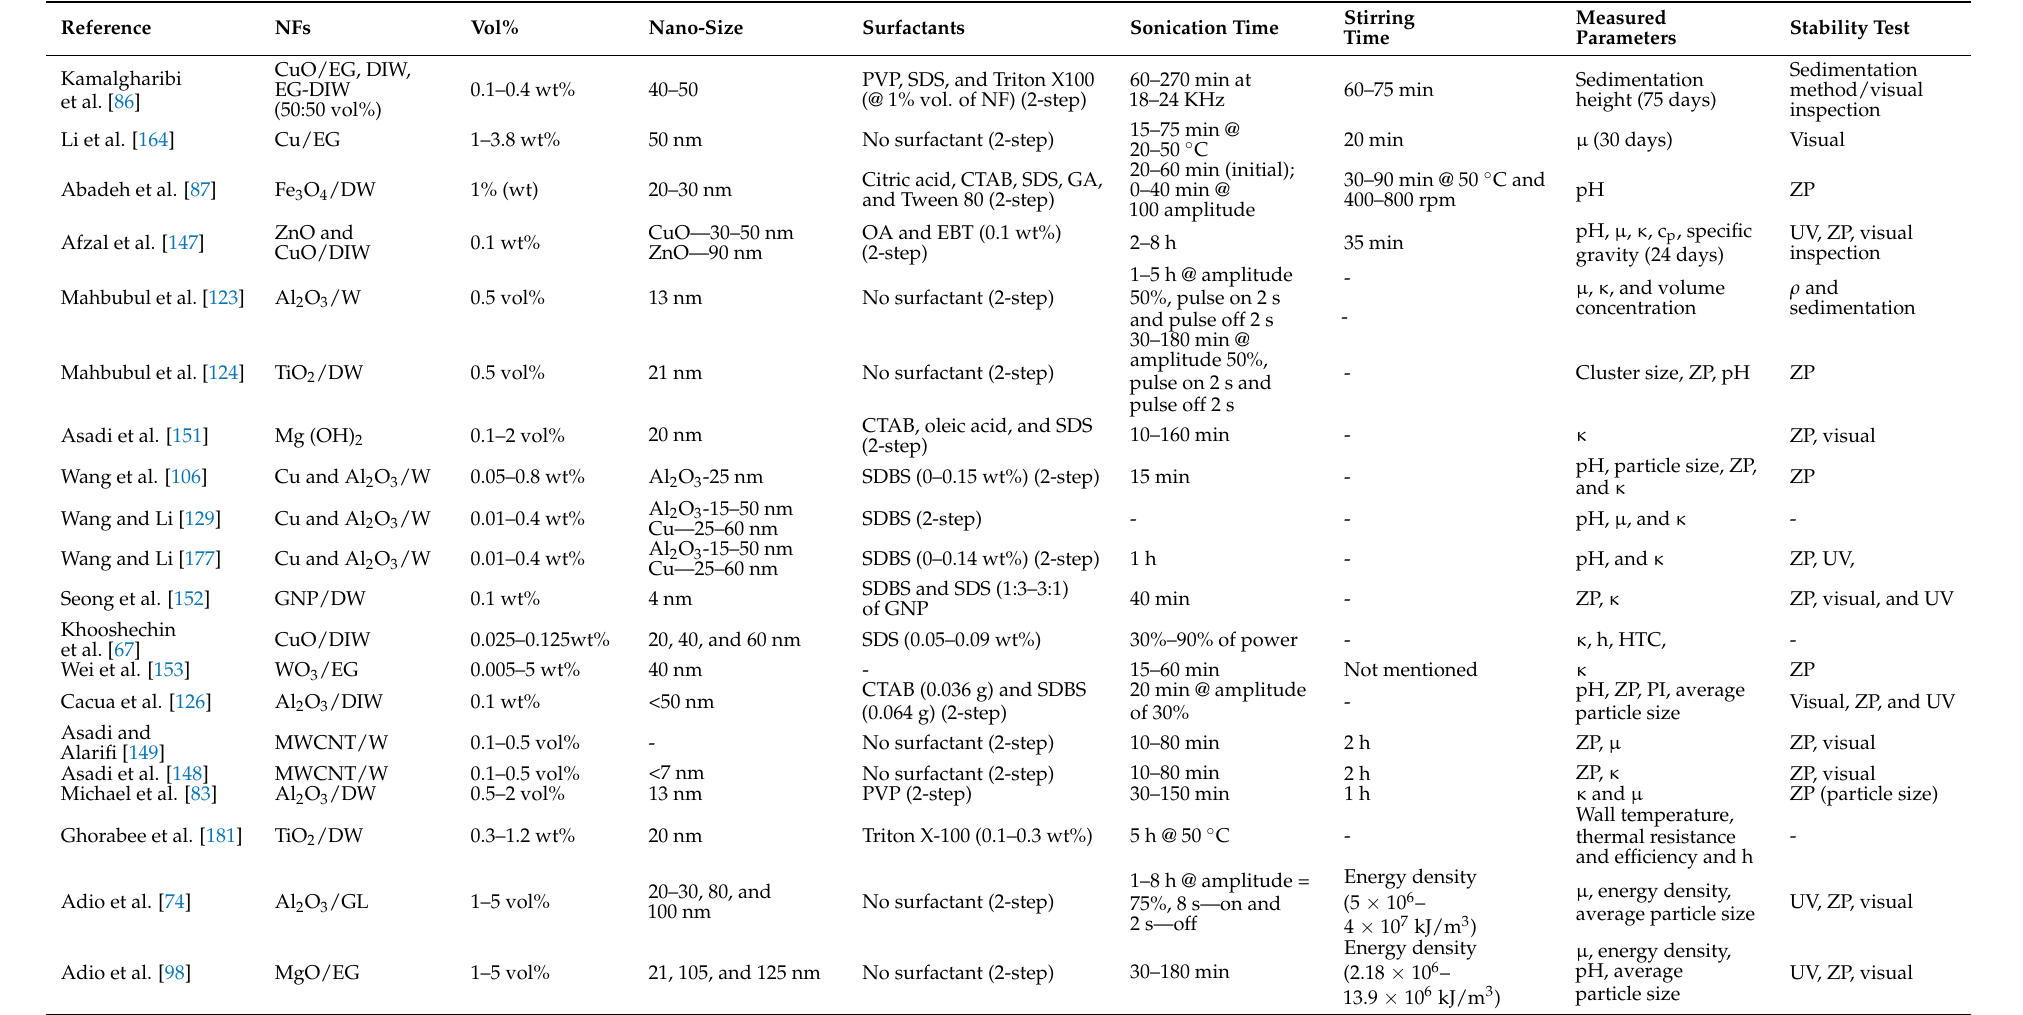
Table 5. Preparation characteristics, stability tests, properties, and performance of mono